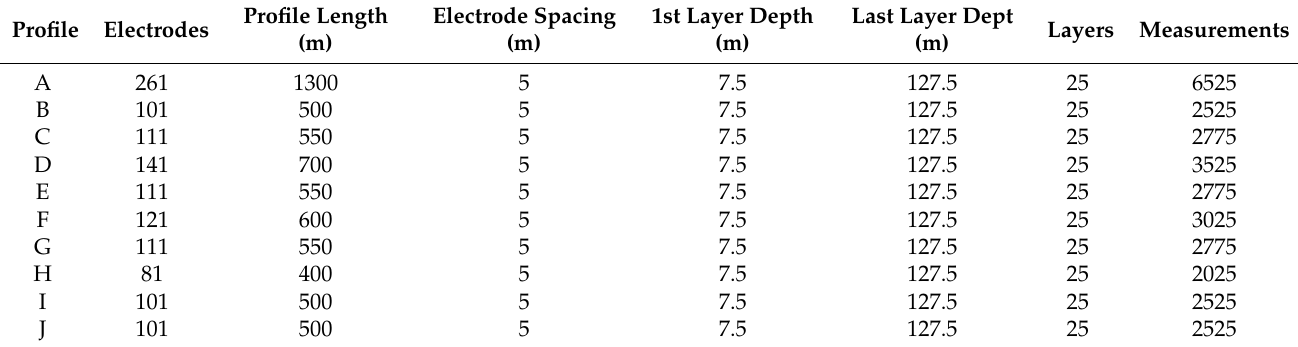
Table 1. Data acquisition parameters of geophysical survey (ERT, IP and SP) including profile name, total number of electrodes for each profile, total profile length, electrode spacing along each profile, depth of first layer, depth of last layer, total layers (depth levels), and total number of